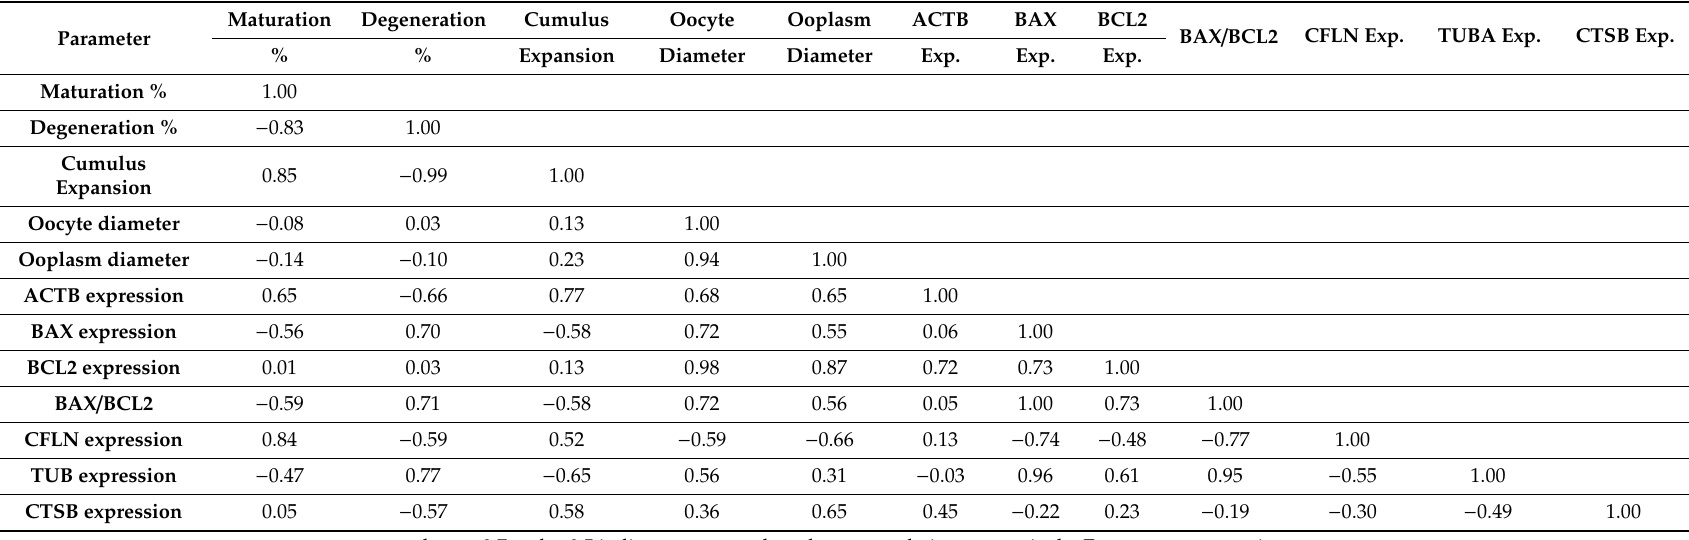
CFLN Exp. TUBA Exp. CTSB Exp.